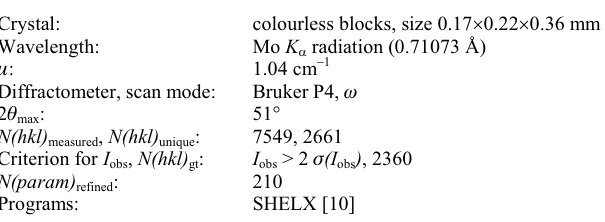
Table 1. Data collection and handling.